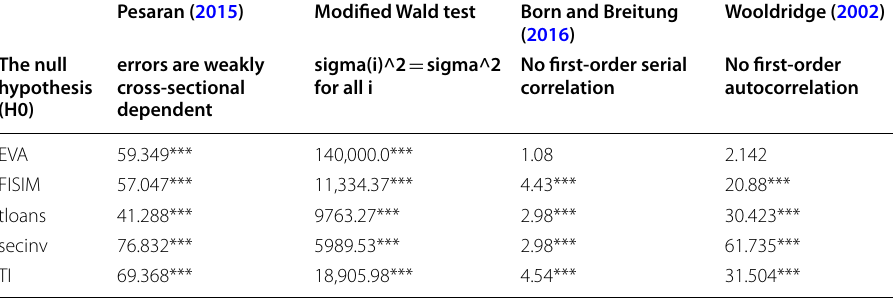
Table 4 Regression diagnostic